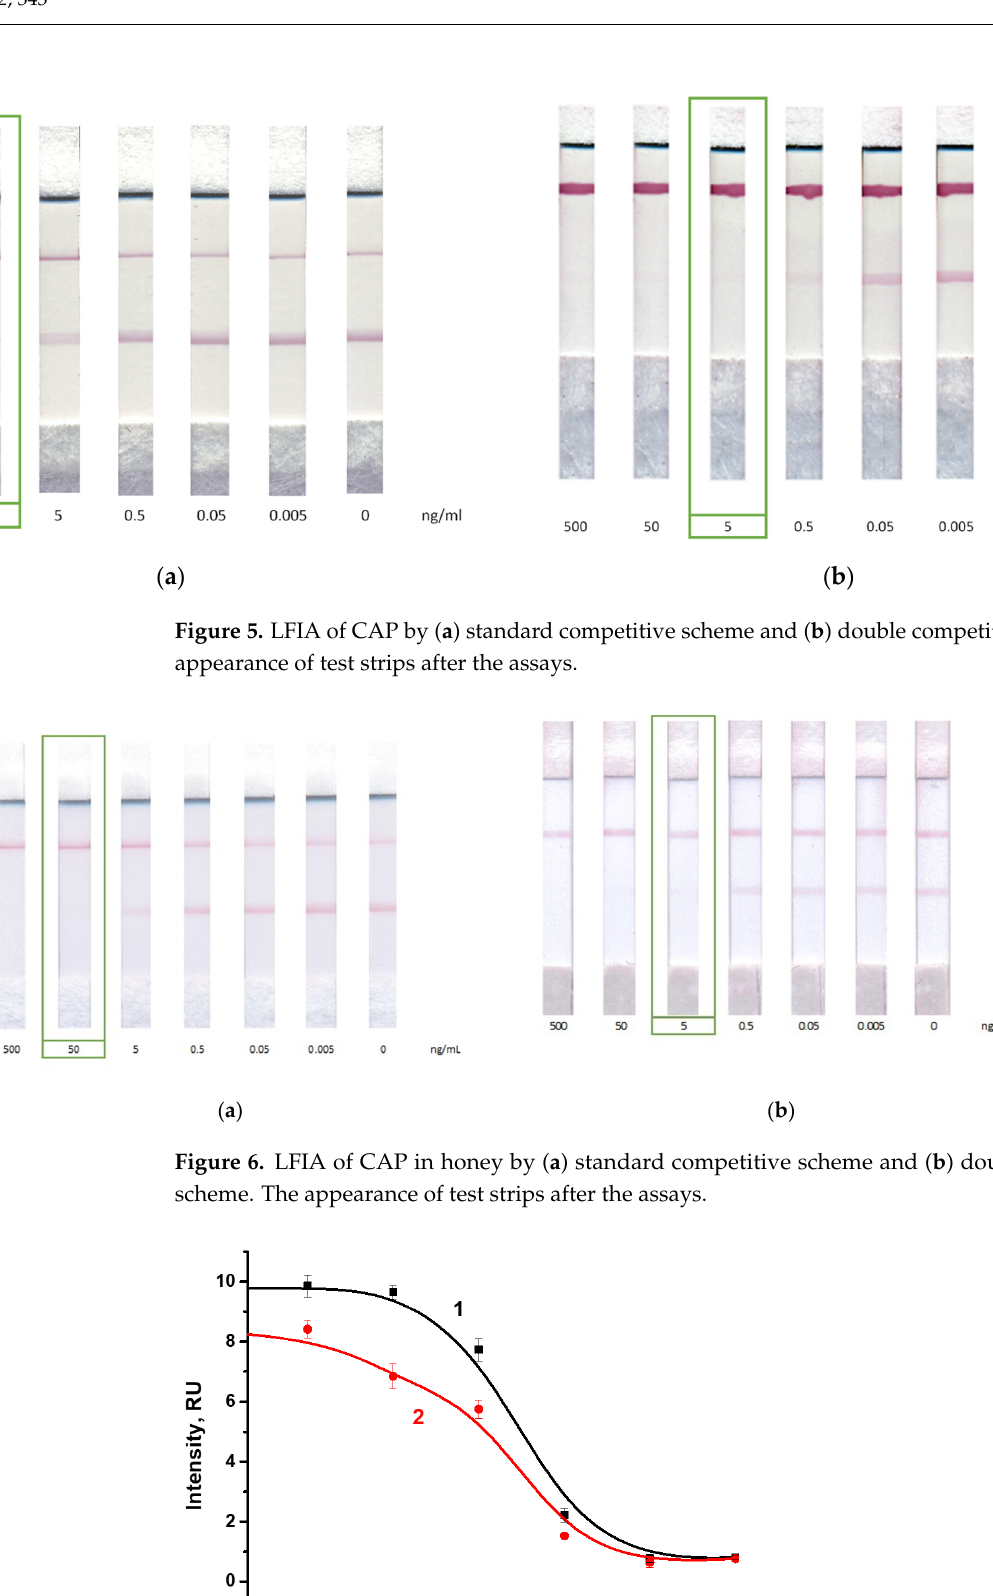
Figure 6. LFIA of CAP in honey by ( a ) standard competitive scheme and ( b ) double competitive scheme. The appearance of test strips after the assays.